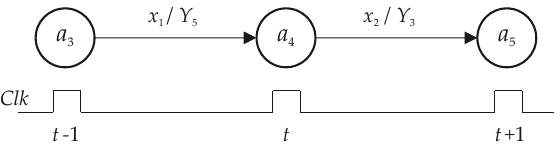
Figure 5. Illustration of the main idea of proposed method.